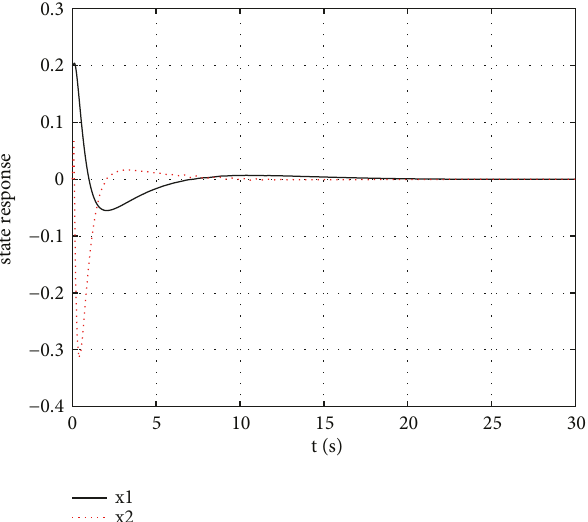
Figure 6: Group 2: the response of state.